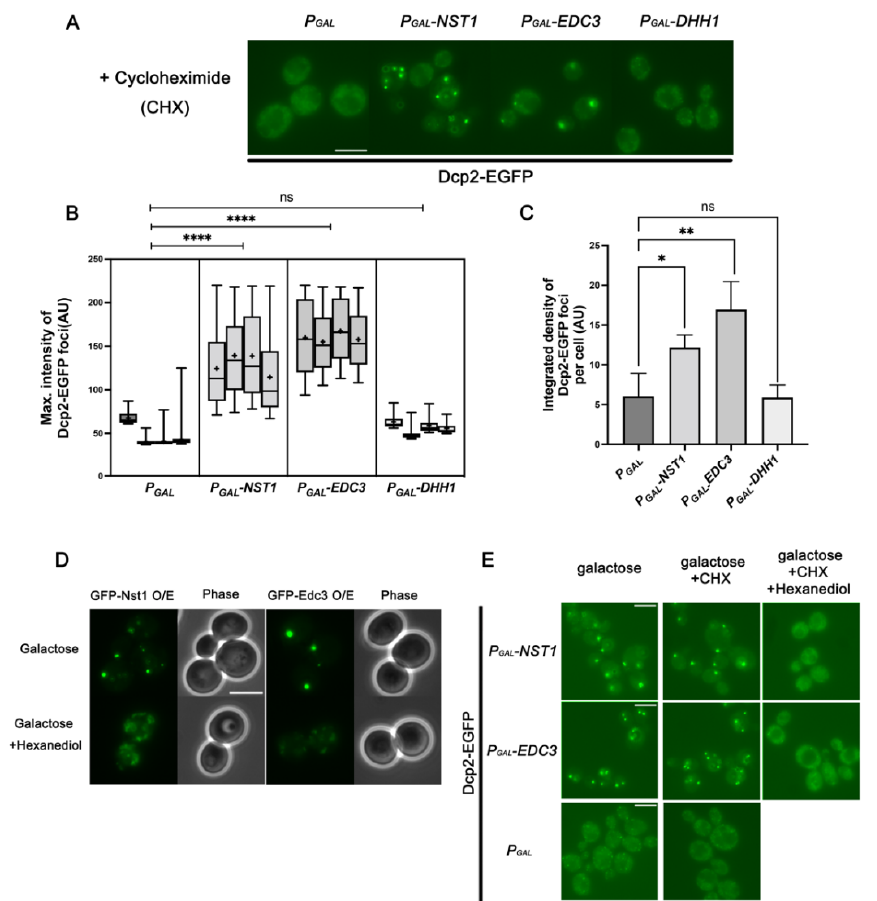
Figure 5. Dcp2-EGFP condensation induced by Nst1 and Edc3 overexpression is maintained in CHX-treated cells but has a liquid-like property. ( A – C ) Dcp2-EGFP condensation after the induced expression of vector control, Nst1, Edc3, and Dhh1. Cells, whose chromosomal DCP2 was tagged with EGFP (YSK3485), were transformed with pMW20-pGAL (vector control), pMW20-pGAL-NST1 , pMW20-pGAL-EDC3 , and pMW20-pGAL-DHH1. After raffinose-galactose induction, each strain was treated with 100 µ g/mL CHX, incubated for 10 min, and observed. ( A ) Fluorescence microscopy of Dcp2-EGFP after CHX treatment in the cells expressing ectopic Nst1, Edc3, and Dhh1. Scale bar, 5 µ m. ( B , C ) More than 200 cells of each strain were monitored for one independent experimental analysis, and every experiment was repeated four times. Pixels of top 0.05% Dcp2-EGFP signal intensity were segmented for the analysis. The segmentation and quantification methods applied to the images are described in the Section 4. ( B ) Monitoring maximum signal intensities of Dcp2-EGFP puncta in ( A ). The maximal intensity of segmented puncta was plotted on the y -axis and presented using a boxplot. The error bar shows mean values ± standard error of the mean (SEM). Statistical significance was determined using a nested t test (* p < 0.05, ** p < 0.01, **** p < 0.0001). ( C ) Quantitative analysis of Dcp2-EGFP puncta per cell of ( A ). Total integrated density of Dcp2-EGFP condensates in the vector-only control and Nst1-, Edc3-, and Dhh1-overexpressed cells was determined. The error bar shows mean values ± standard error of the mean (SEM). Statistical significance was determined using a Student’s t test (* p < 0.05, ** p < 0.01, **** p < 0.0001). ( D ) Fluorescence microscopy of GFP-Nst1 and GFP-Edc3 condensates induced in the wild-type cells by their overexpression (top) and after further treatment with 10% 1,6-hexanediol (bottom). Overexpression of GFP-Nst1 and GFP-Edc3 was induced in BY4741 wild-type cells (YSK3483) transformed with P GAL -GFP , P GAL -GFP-NST1 , and P GAL -GFP-EDC3 , respectively, using raffinose-galactose induction procedures described in the Section 4. Cells containing GFP-Nst1 and GFP-Edc3 condensates were treated with 10% hexanediol for 1 h. Scale bar, 5 µ m. ( E ) Fluorescence microscopy of endogenous Dcp2-EGFP condensation induced by the overexpression of Nst1 and Edc3 (left) and by CHX treatment following their